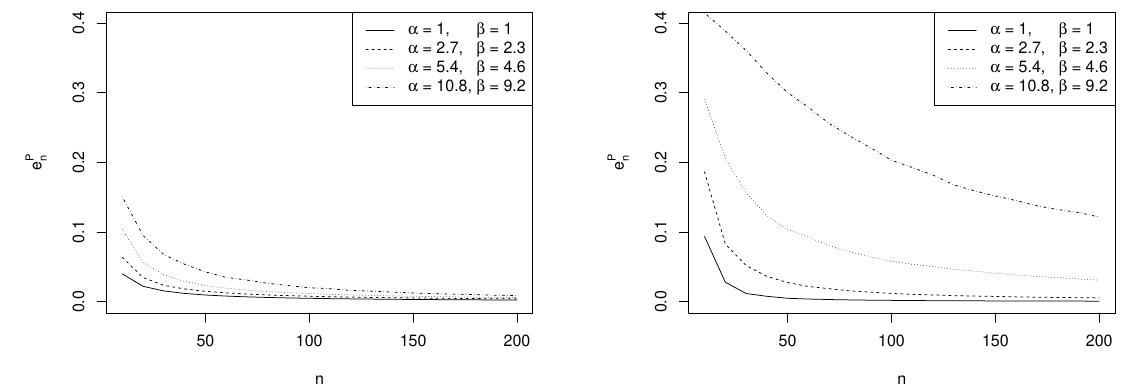
Figure 2. Plots of e P n as a function of n for several values of the prior hyperparameters ( α , β ) , with θ d = 0.45 ( left column ) and θ d = 0.8 ( right column